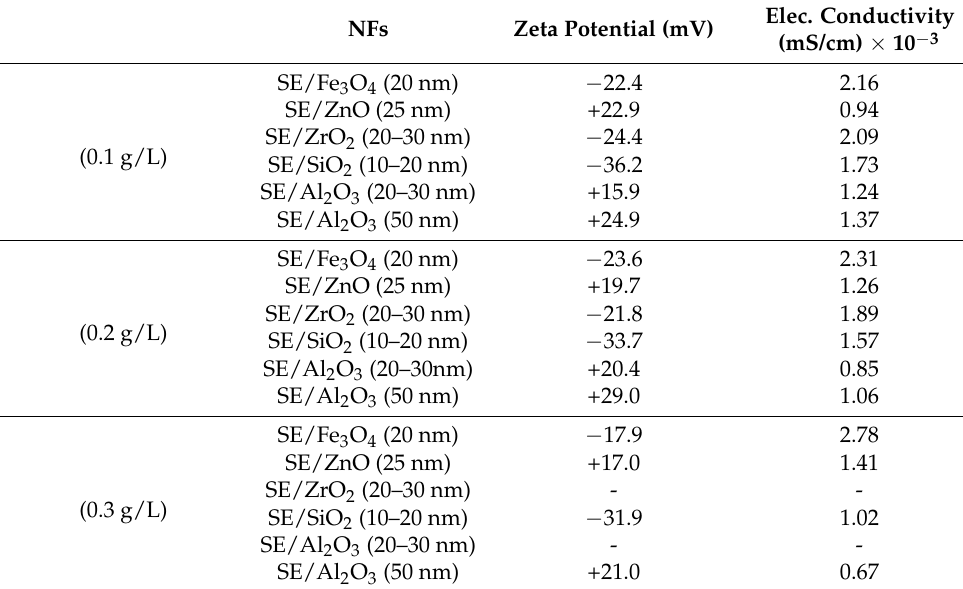
Table 3. Zeta potential and electrical conductivity of nanofluids